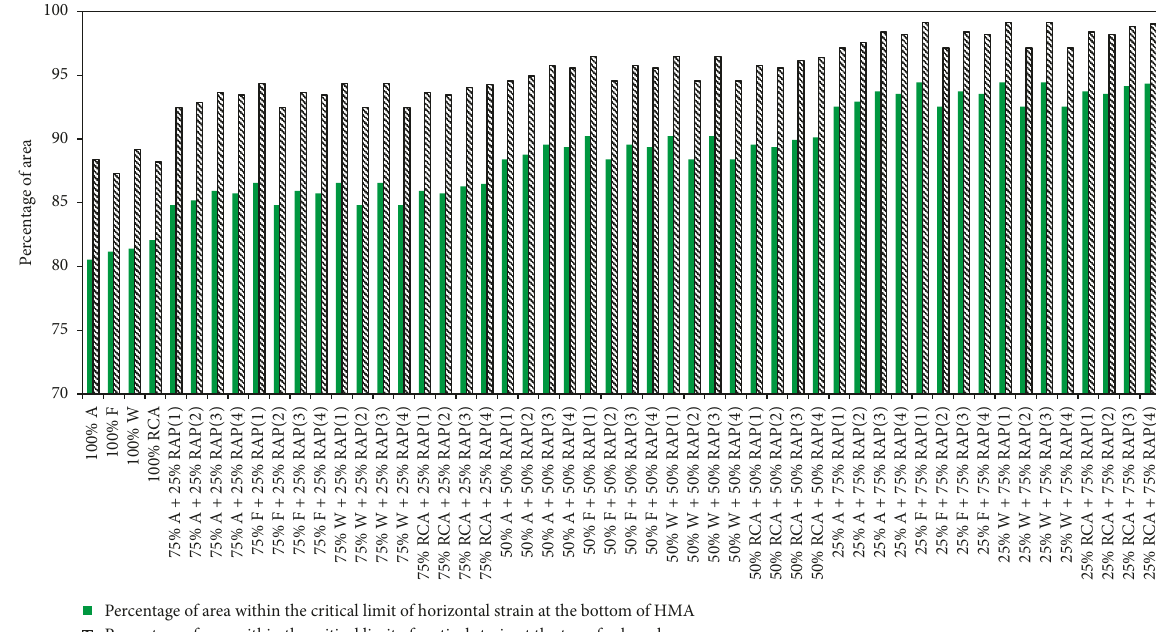
Percentage of area within the critical limit of horizontal strain at the bottom of HMA Percentage of area within the critical limit of vertical strain at the top of subgrade Figure 10: Percentage of area within the critical limits for horizontal strain at the bottom of HMA and vertical strain at the top of subgrade.